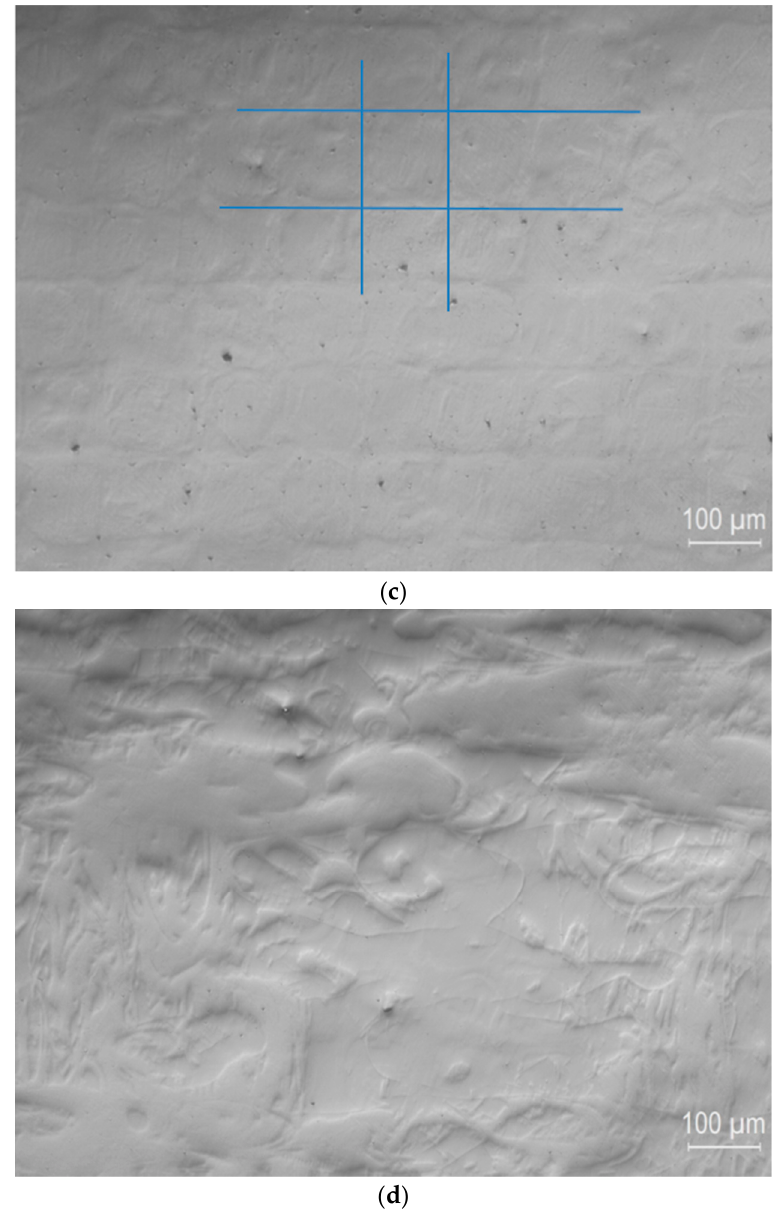
Figure 3. Micrographs showing planar x–y views of the UNSMed ( a – c ) and the as-built surfaces ( b – d ), acquired by optical microscope at two magnifications.